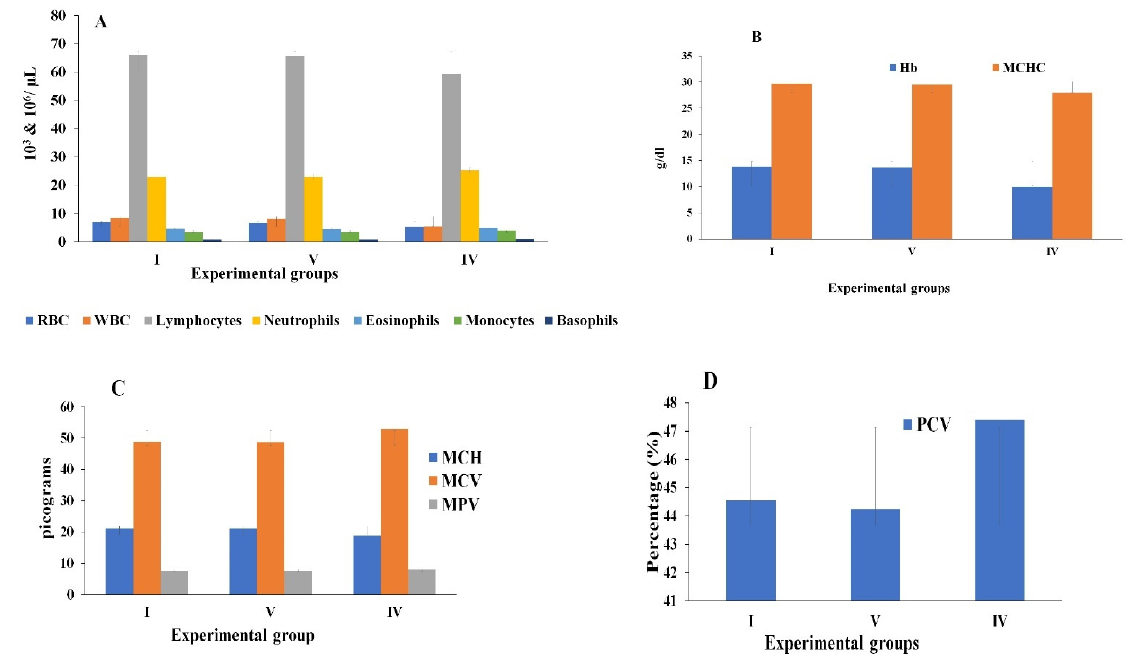
Figure 2. Analysis of hematological parameters in treated and control Albino mice. The data presented as mean value ± SE ( n = 3). Group I: Control; Group V: survival (1250 mg/kg); Group IV: lethal (1500 mg/kg). ( A ) Blood hematological analysis (RBC: Red Blood Corpuscles; WBC: White Blood Corpuscles); ( B ) Hb: Hemoglobin; MCHC: Mean Corpuscular Hemoglobin Concentration; ( C ) MCH: Mean Corpuscular Hemoglobin; MCV: Mean Corpuscular Volume; and MPV: Mean Platelet Volume; ( D ) Packed Cell Volume (PCCV) analysis.